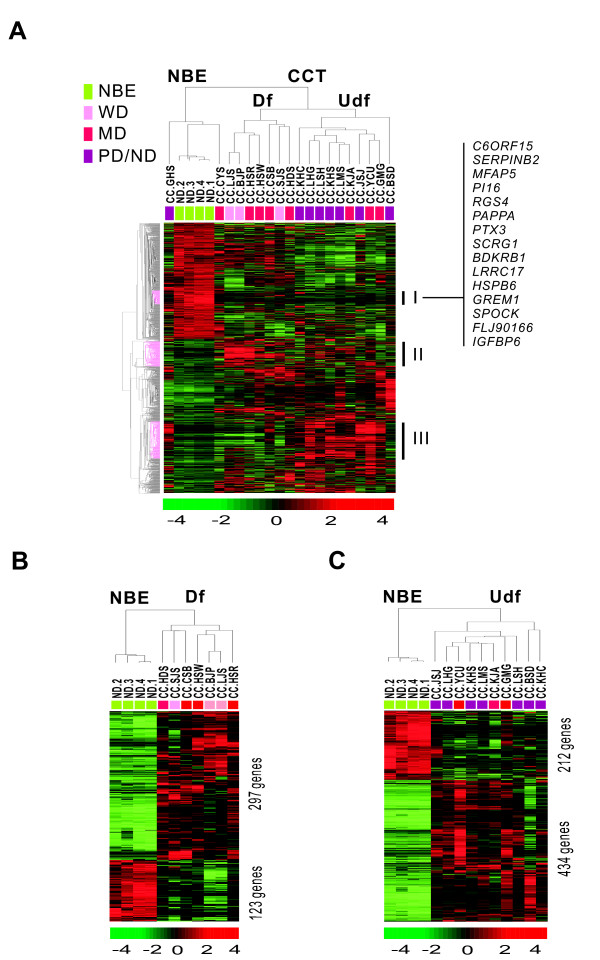
Unsupervised hierarchical clustering of 4 biliary epithelial cells and 19 CC tissues. (A) Unsupervised hierarchical clustering separated the samples into two main groups. We selected 1798 unique genes with two-fold or greater difference from the mean with P < 0.01 by t-test for hierarchical clustering analysis. Specific gene clusters (Cluster 1 through Cluster III) were identified of differentially expressed in CCT compared to NBE. (B) Supervised hierarchical clustering of four biliary epithelial cells and seven differentiated CC tissues. We selected 420 unique genes with four-fold or greater difference from the mean and P < 0.01 by t-test for hierarchical clustering analysis. (C) Supervised hierarchical clustering of 4 biliary epithelial cells and 10 undifferentiated CC tissues. We selected 646 unique genes with the criteria in B for hierarchical clustering analysis.